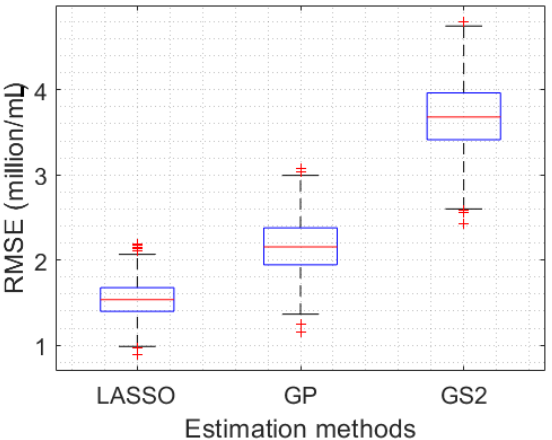
Figure 11. Boxplots of RMSEs obtained by the proposed approach compared with those obtained by GP [16] and GS2